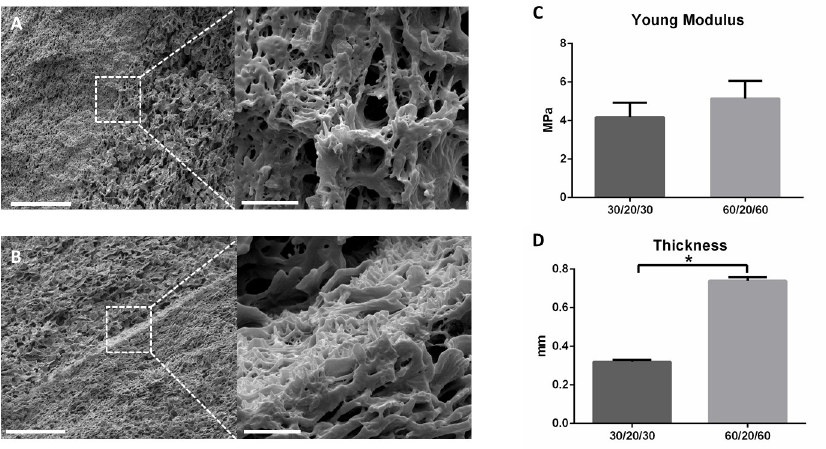
Fig 4. Embedded PLA fibers between two PLC films FE-SEM cross-section images. A) 30 minutes and B) 60 minutes of PLA fibers production (scale bar = 30 microns. Inserts: scale bar = 3 microns). C) Young Modulus and D) thickness measurements of the different conditions (n = 3, � P <